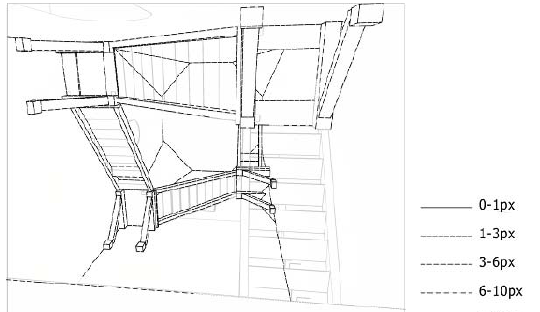
Figure 10. Mismatches of the model and the image. Image resolution is 2560x1920px.